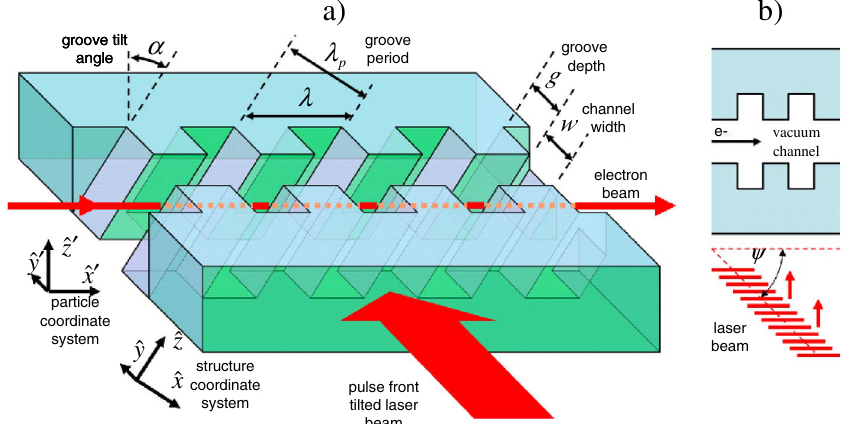
FIG. 1. (Color) (a) Perspective view of a section of the proposed deflection structure element. (b) Top view of a section of the structure. While the periodic grooves maintain phase synchronicity, the laser pulse-front tilt guarantees synchronicity of the laser pulse envelope with the relativistic electron bunch traveling in the vacuum